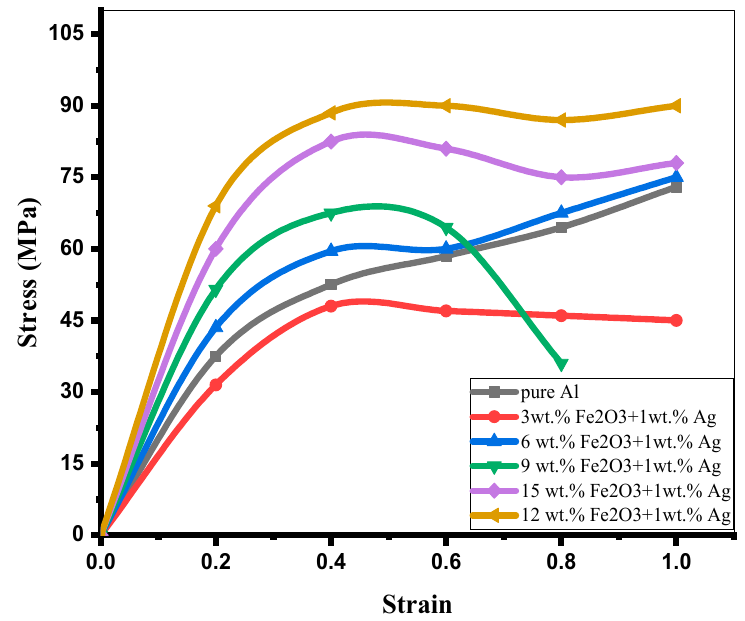
Figure 5. The stress–strain diagrams of pure Al and Al/Fe 2 O 3 + Ag hybrid nano ‐